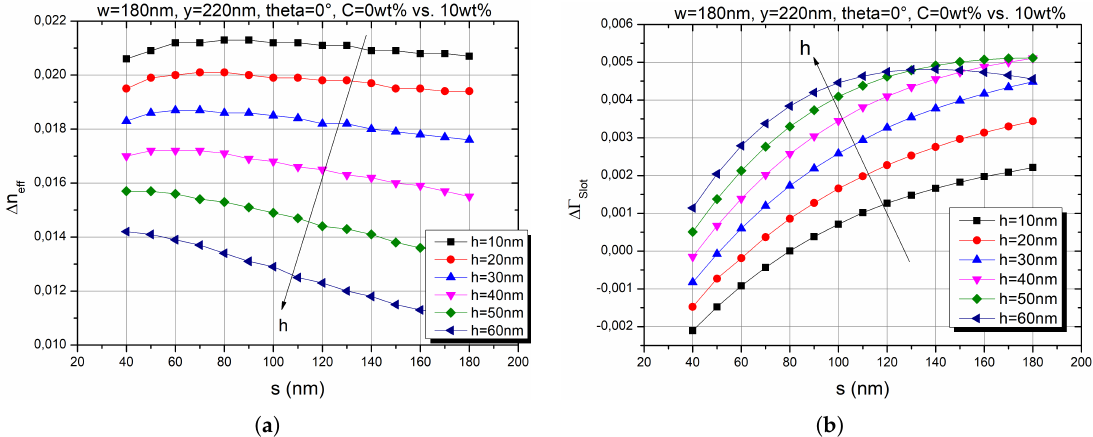
Figure 10. Difference in the effective refractive index ∆ n eff ( a ) and the field confinement factor ∆Γ slot ( b ) of both concentrations as a function of s , with h as parameter.